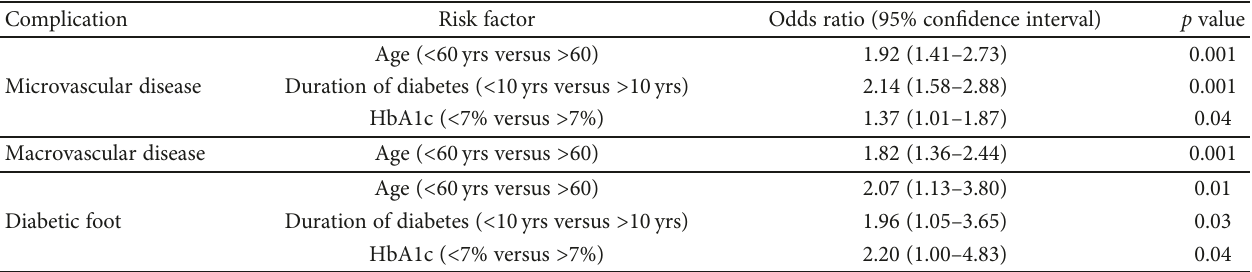
Table 4: Comparison of chronic complications with other regions in Asia.